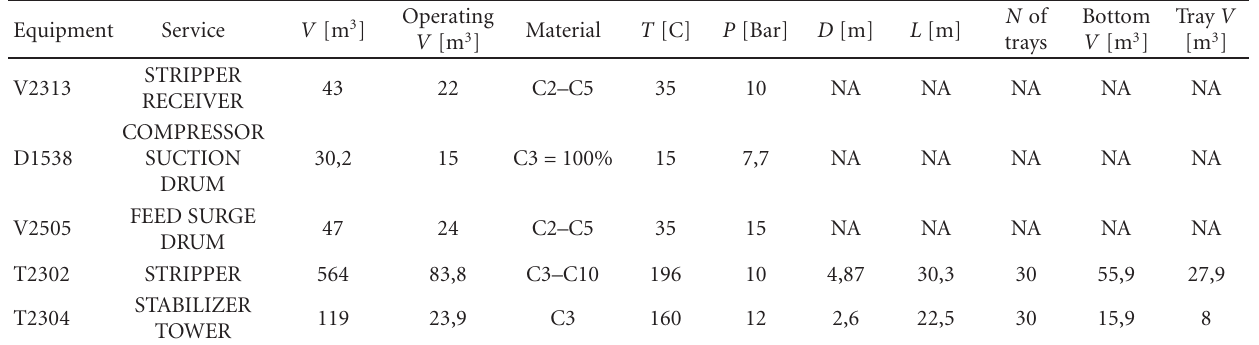
Table 1: Data given by the client to Broker A and Broker B to use in their modelling.